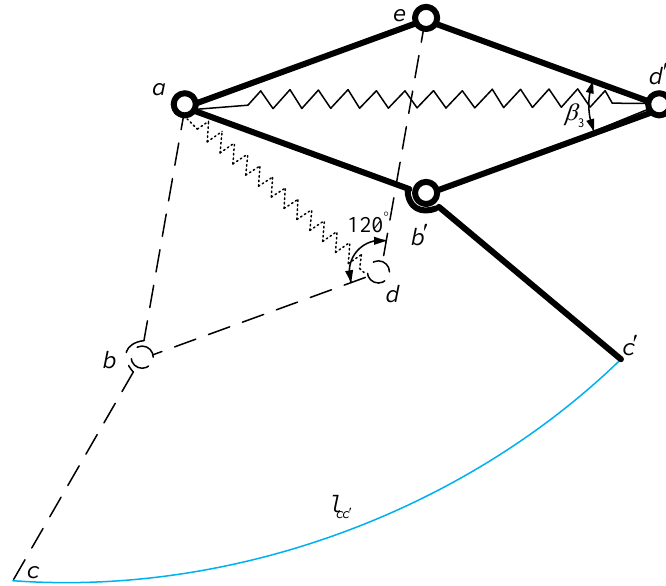
Figure 16. Trajectory of the end of the hind limbs when loading.